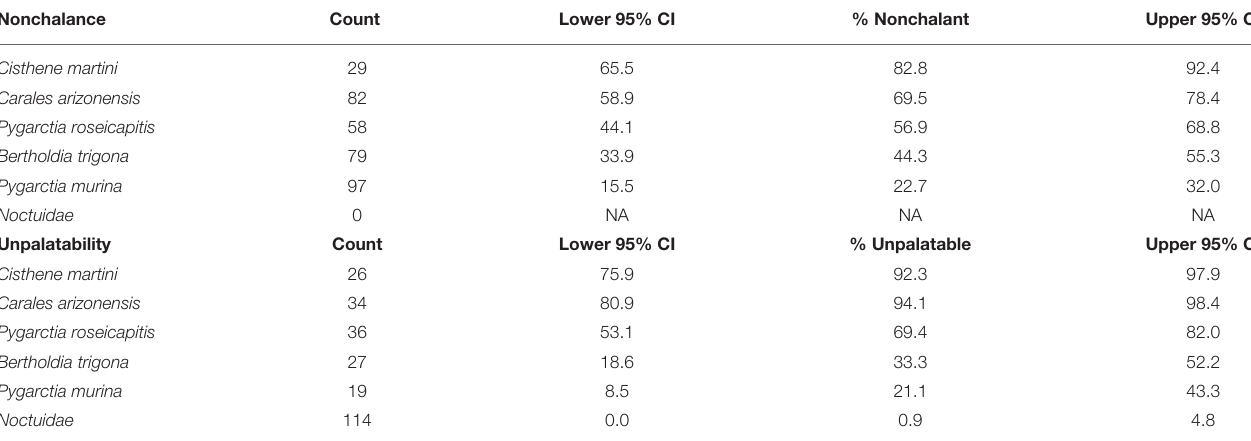
TABLE 4 | Summary of nonchalance and unpalatability